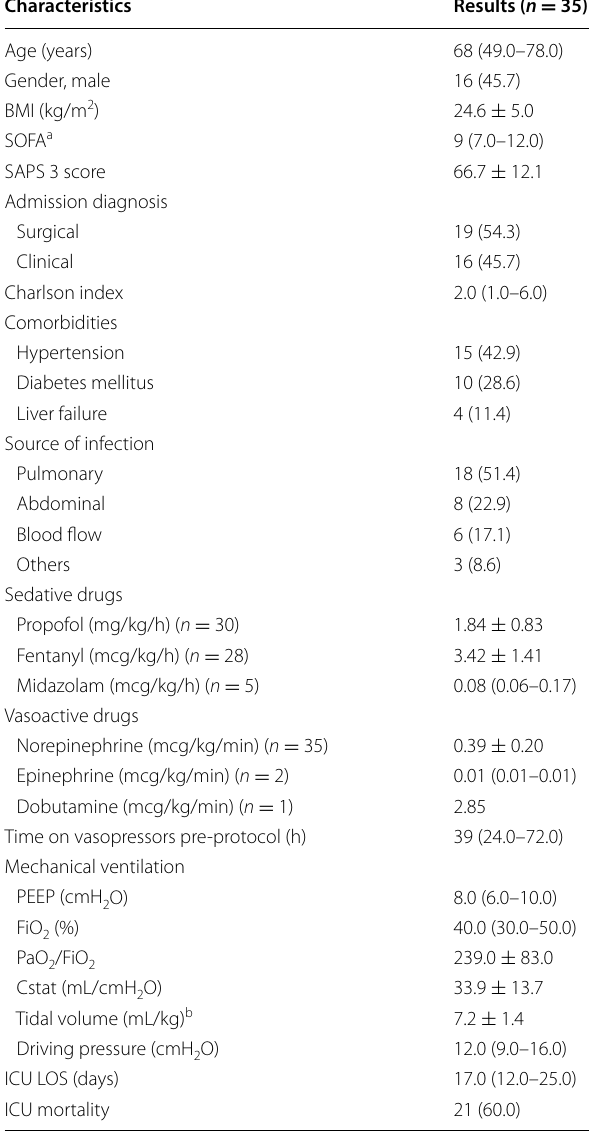
Table 1 Baseline characteristics and clinical data of the study population